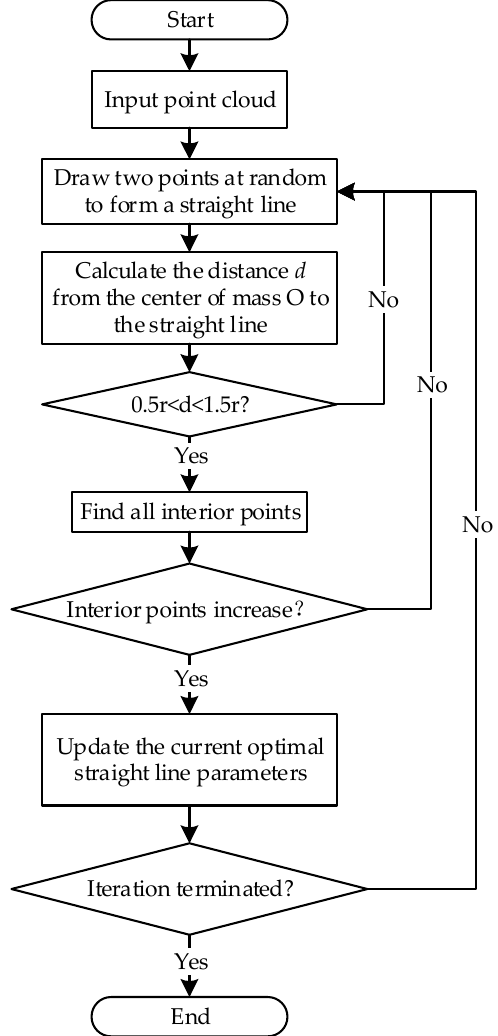
Agriculture 2022 , 12 , x FOR PEER REVIEW Figure 8. Flowchart of spatial line detection algorithm using RANSAC. Figure 8. Flowchart of spatial line detection algorithm using RANSAC.